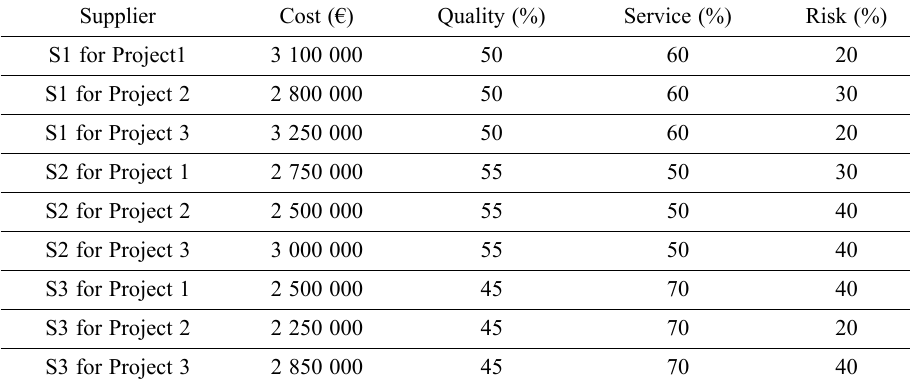
Table 14. Data set for suppliers with regards to the